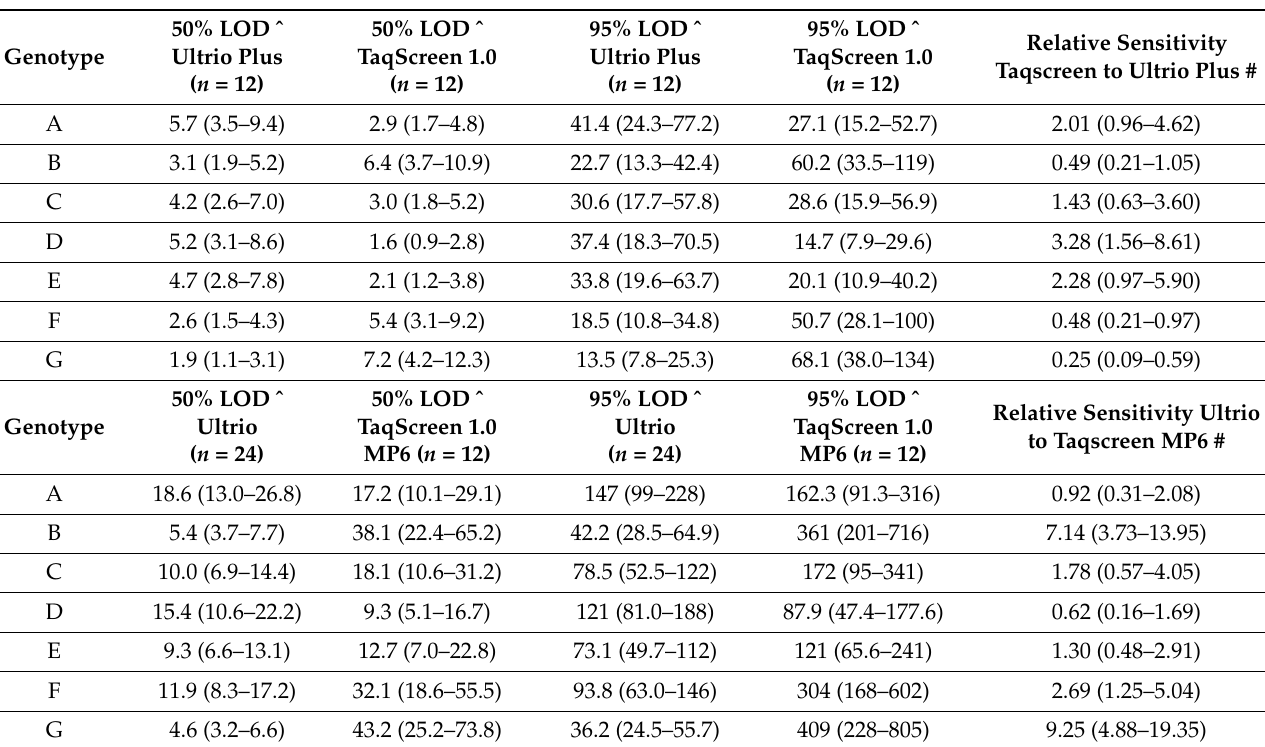
Table 3. Analytical sensitivity of TaqScreen 1.0 relative to Ultrio Plus (upper table) and previous Ultrio version relative to TaqScreen 1.0 in MP6 format (lower